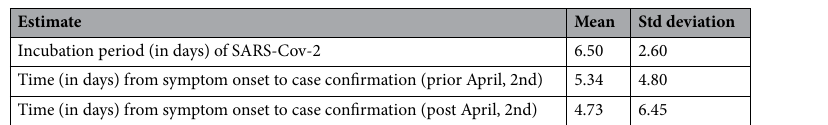
Table 1. Mean time and corresponding standard deviation for calibration of distribution of daily incidences of non-observed series.